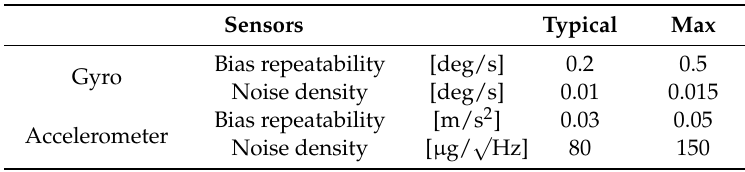
Table 1. MTi-G710 Parameters.